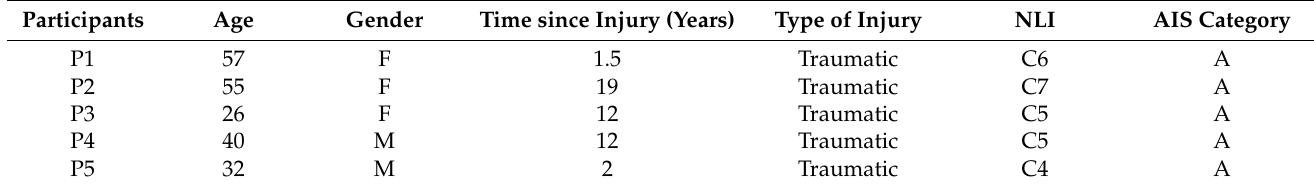
Table 1. The demographic and clinical characteristics of the participants.